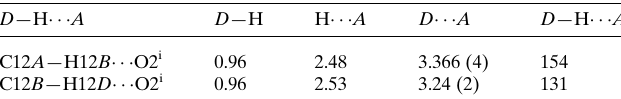
Table 1 Hydrogen-bond geometry (A˚ , (cid:5)